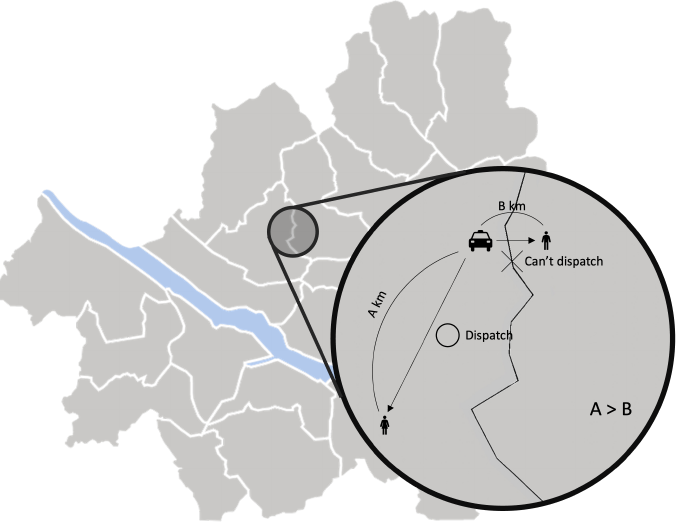
Figure 12. Zone-sensitive approaches did not allow the taxis to pick up a passenger in another service zone even though they are nearer than any other passengers within its zone. This is because the zone-sensitive approaches must determine the fleet proportions to different destination zones prior to matching taxis and passengers